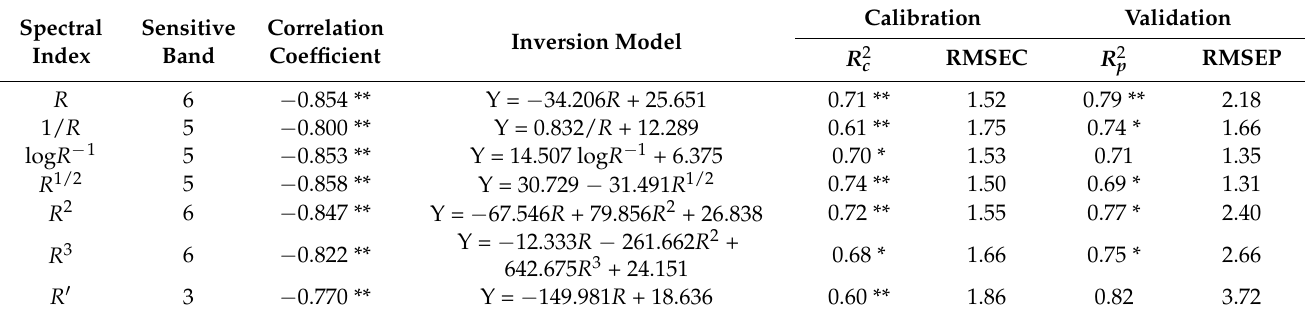
Table 6. Single-band inversion model of soil organic matter content based on spectral